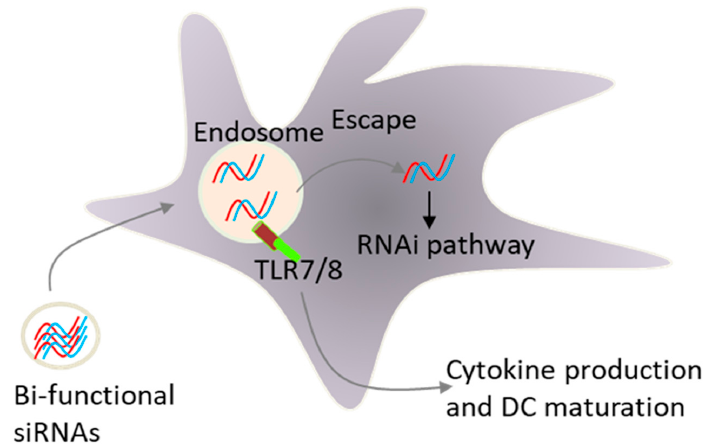
Figure 5. Combined gene silencing and Toll-like receptor TLR activation by a single siRNA